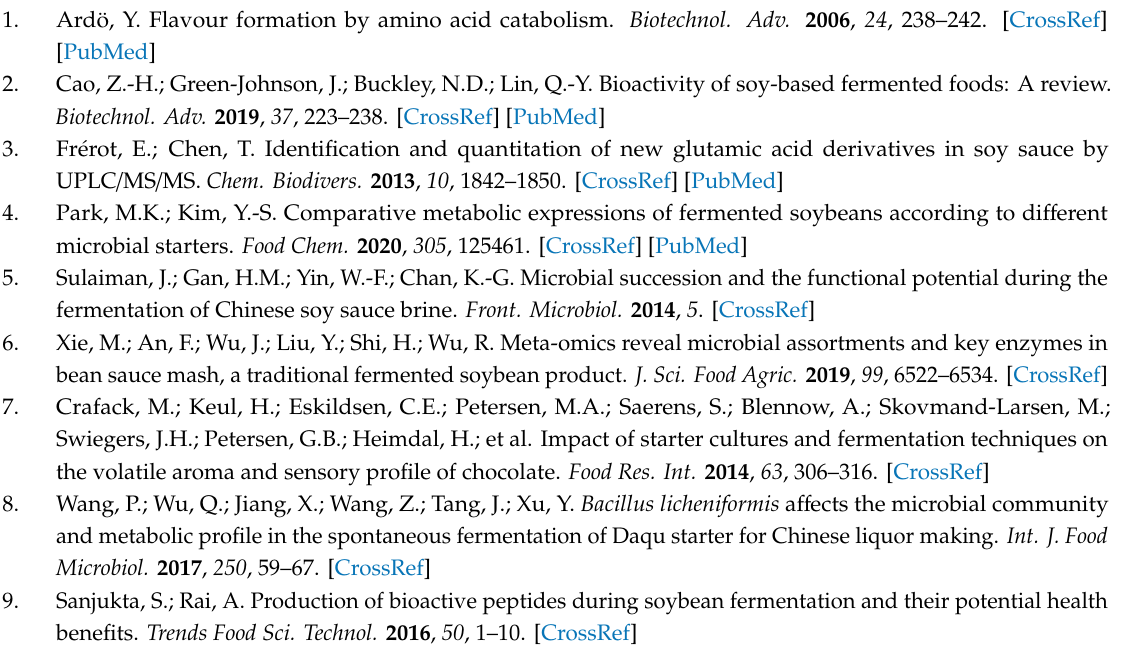
Figure S1: The bacterial and fungal biomasses in moromi. Table S1: The sequencing reads, OTU numbers and Good’s coverage. Table S2: Spearman correlation coe ffi cient between microbes and metabolites. Table S3: Strain list cultured from moromi